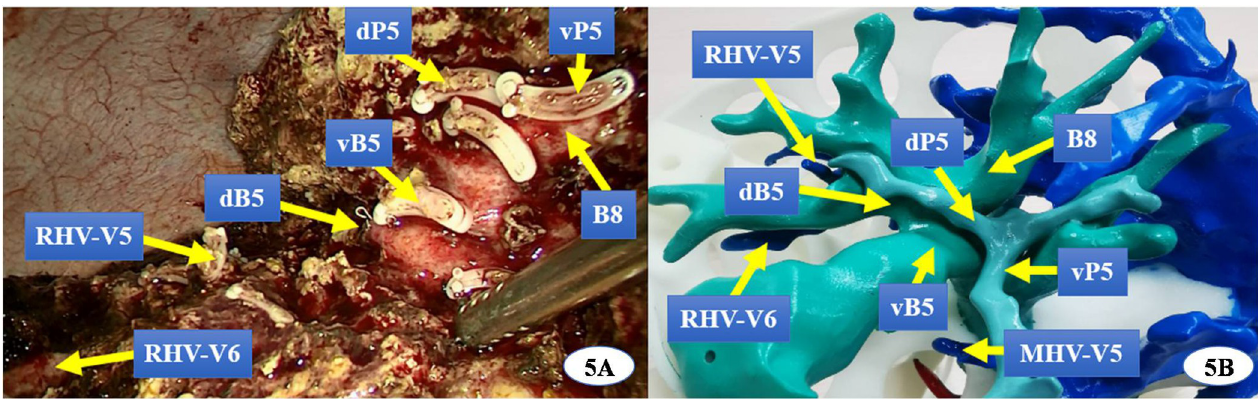
Fig 5. The actual intrahepatic ducts of surgical field were reconfirmed consistently with the liver model’s after operation. (dP5:the dorsal portal vein of segment 5, vP5:the ventral portal vein of segment 5,vB5: the ventral bile duct of segment 5, dB5: the dorsalbile duct of segment 5, B8: thebile duct of segment 8, RHV: right hepatic vein, RHV-V5: The venous reflux of hepatic segment 5 to RHV,RHV-V6: The venous reflux of hepatic segment 6 to RHV).